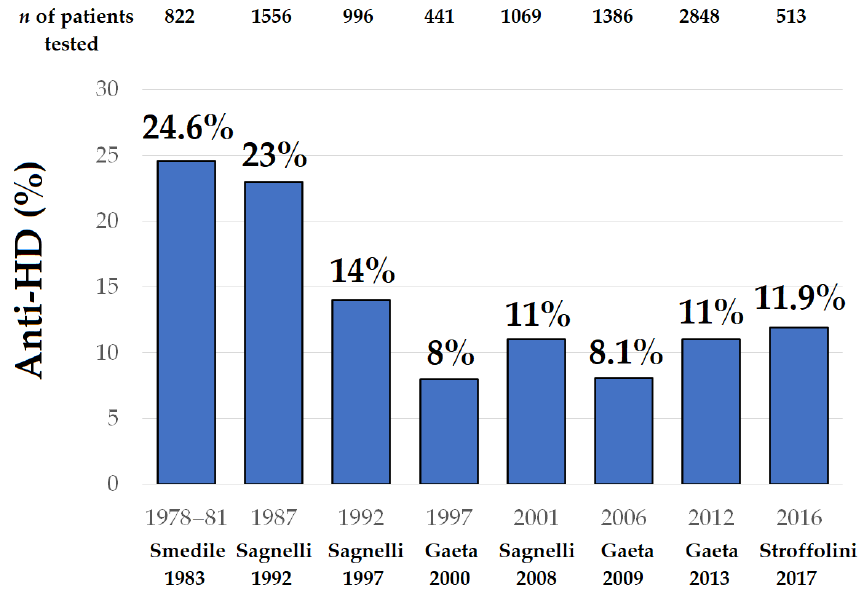
Figure 5. Decline in anti-HD in HBsAg carriers with liver disease in Italy by the end of last century and return of the antibody with migratory fluxes in the last two decades. Abbreviations: anti-HD, antibodies to hepatitis D; n , number. Table 2. HDV infection in 2021 in high-income countries: the paradigm of Italy. HDV vanishing in the domestic population, accounting for about 5000 patients with fibrotic/cirrhotic disease (mean age of 58 years in 2020)